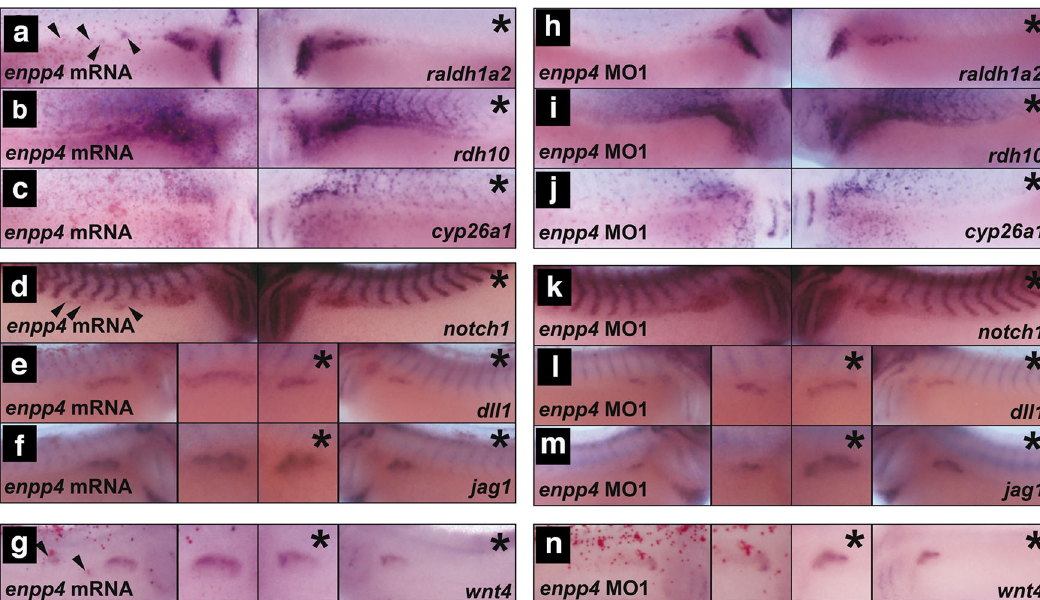
Fig. 4 Microinjection of enpp4 mRNA and MO affect the expression of retinoic acid synthesis enzymes, notch and wnt signalling molecules. a – g Embryos targeted with 2 ng of enpp4 and 250 pg of LacZ mRNA or h – n 10 ng of enpp4 MO1 and 250 pg of LacZ mRNA were fi xed at stage 28 and examined by whole-mount in situ hybridization with the following probes: raldh1a2 ( a , h ), rdh10 ( b , i ), cyp26a1 ( c , j ), notch1 ( d , k ), dll1 ( e , l ), jag1 ( f , m ) and wnt4 ( g , n ). The asterisks denote the control, uninjected sides. Arrowheads indicate ectopic staining of the marker gene (see also Supplementary Table 3 and Supplementary Fig.